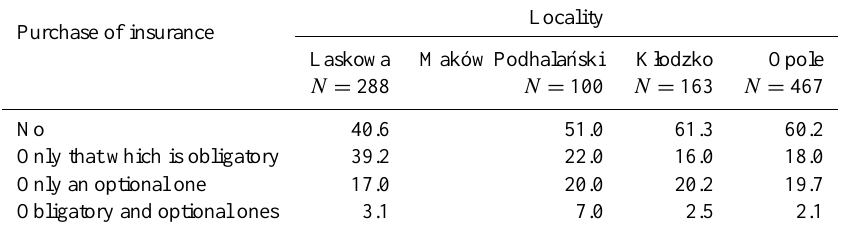
Table 7. Share of the respondents (%) declaring that they have purchased insurance policies.